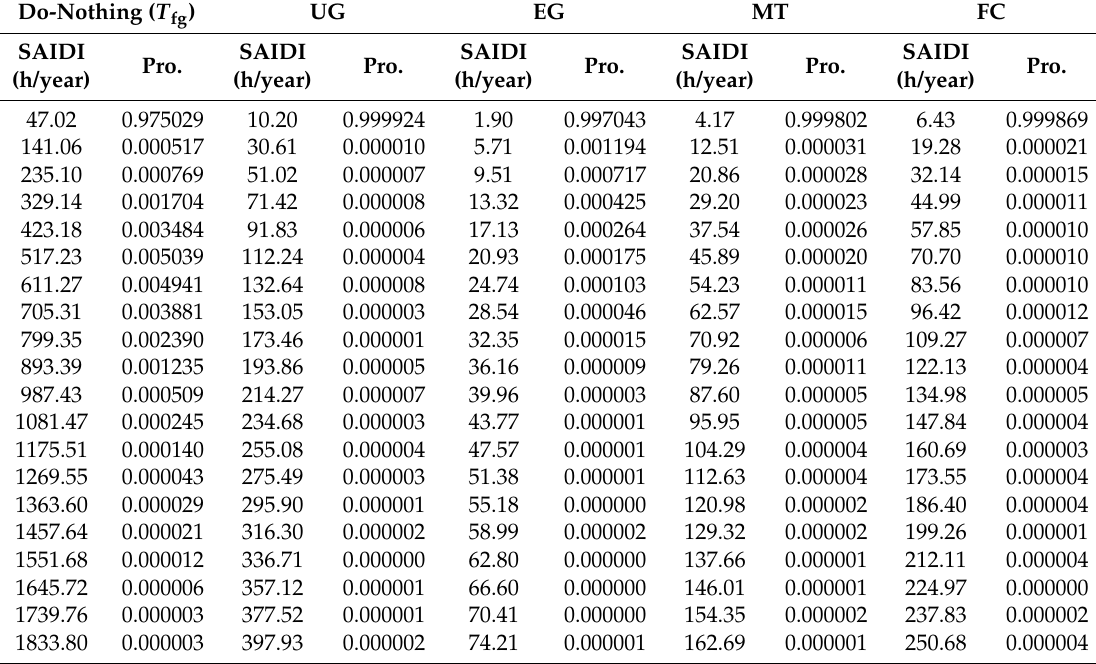
Table 2. Reliability data of hardening options (Town A). SAIDI: system average interruption